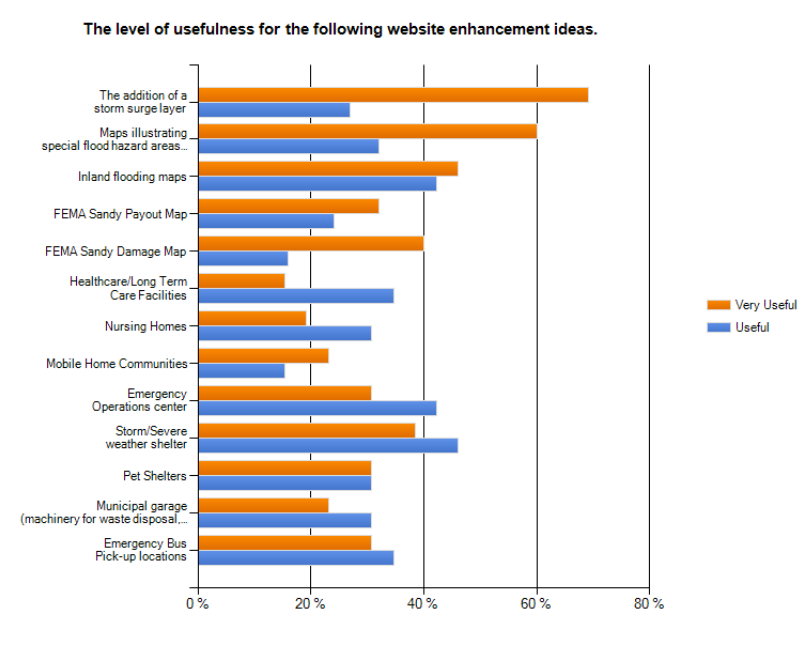
Figure 6. A bar chart indicating the level of usefulness for a variety of proposed NJFloodMapper website enhancements. Choices given to respondents included “very non-useful”, “non-useful”, “I don’t feel strongly either way”, “useful” and “very